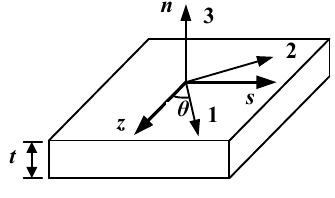
Figure 6. Load–strain curves of the three different composite sandwich laminated box beams.